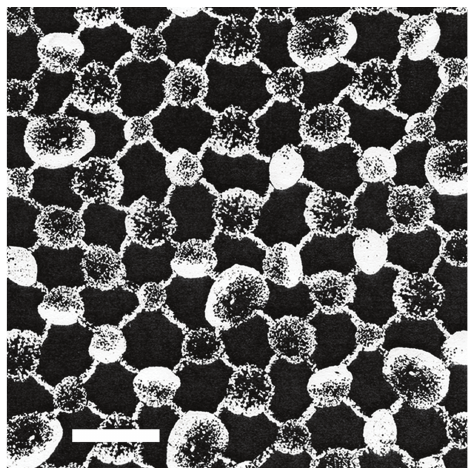
Figure 1: Reconstructed high-periodicity meshwork of the blood leukocyte glycocalyx composed of individual natural nanopar- ticles. The meshwork composition is projected onto a plane. Electron microscopy: the bar corresponds to the minimum size of the nanoparticle, which is 50 nm under 15% NaCl electrolyte concentration (hypertonic solution) or 3 nm under 0.9% NaCl electrolyte concentration (isotonic solution) (Golovanov MV, Bauer J, unpublished data personal report,